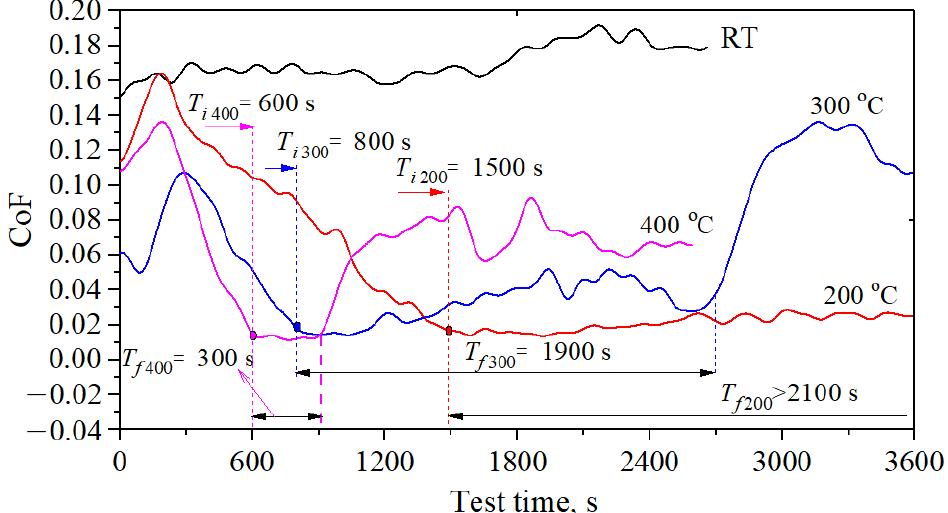
Figure 3. CoF of the friction pair of PRG/WC-Ni alloy under different temperatures. Figure 4 shows SEM images and microscope images of the worn surface of WC-Ni disc under different temperatures. The W, Ni, C, and O elements in the red wire frame area of the friction surface were detected by the energy-dispersive X-ray spectroscopy (EDS). There is a high content of carbon on the worn surface. This confirms that the graphite was transferred to the surface of the cemented carbide disc from the PRG pin. At room temperature, as shown in Figure 4a,b, the transferred graphite films are distributed with uneven and irregular sizes and shapes, such as dots, flakes, and stripes, and the thickness of the transferred film is also uneven. At 200 ◦ C, as shown in Figure 4c,d, the effective contact area between the pin and the disk is relatively small, but the transferred film is stable and continuous throughout the whole wear track. The graphite transferred film at 300 ◦ C is shown in Figure 4e,f. The transferred film is mainly composed of small diameter granular graphite clusters, which are evenly distributed on the wear surface but the density of graphite clusters is low. As shown in Figure 4g,h, the graphite transferred film at 400 ◦ C has a certain area and is continuous and sheet-like. Compared with the graphite transferred film at 300 ◦ C, this sheet-like transferred film is formed by the adhesion of multiple layers of granular graphite clusters under high temperature and multiple interactions. Comparing the images at different temperatures, it can be seen that graphite was formed by a granular or flake-like transferred film on the surface of the cemented carbide under the combined action of high temperature and extrusion and shear stress. The difference is that graphite was formed as a continuous and compact transferred film with a certain thickness on the surface of the cemented carbide at 200 ◦ C, which is conducive to achieving ultra-low friction. As the temperature raised, at 300 and 400 ◦ C, graphite became granularly distributed on the surface of WC-Ni alloy, and a compact continuous transferred film was gradually formed on the surface of the alloy when friction time increased to a certain